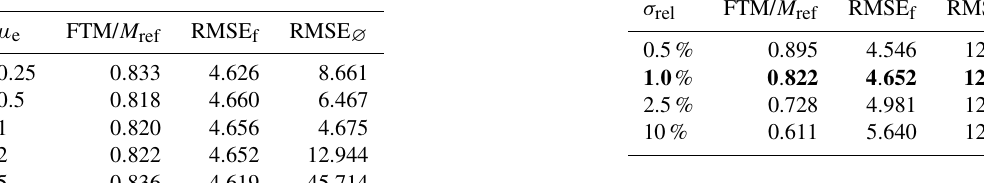
Table 1. Final total mass (FTM) relative to M ref and the concen- tration field RMSE for five different forecast simulations with five different initial total masses µ e . RMSE f and RMSE ∅ are the con- centration field RMSE at the end of simulations with and without assimilation of observations.